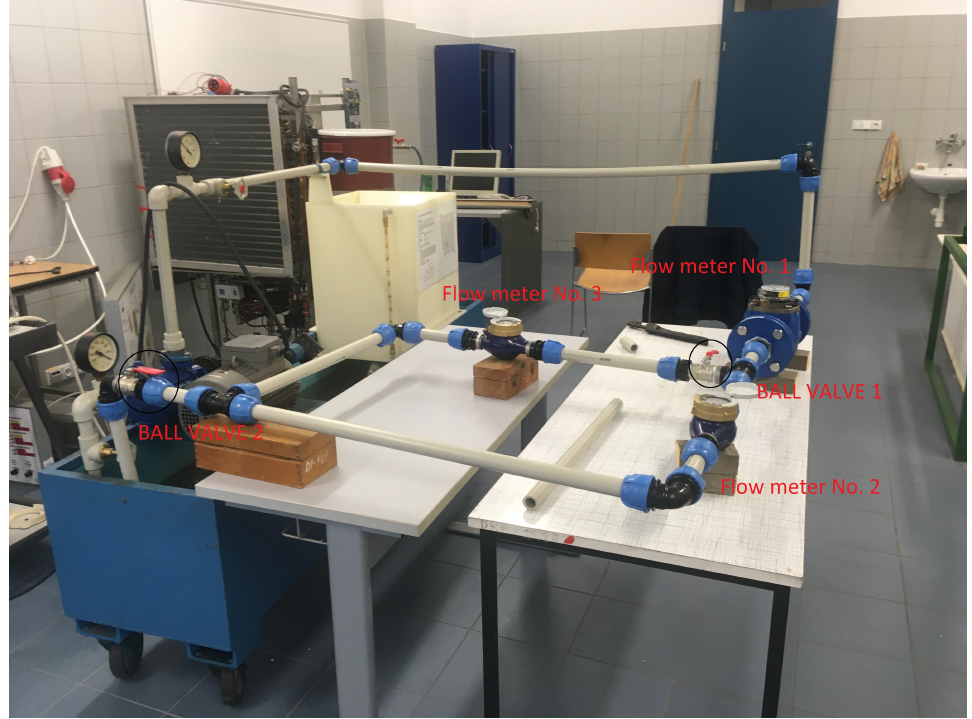
Figure 9. Laboratory testing